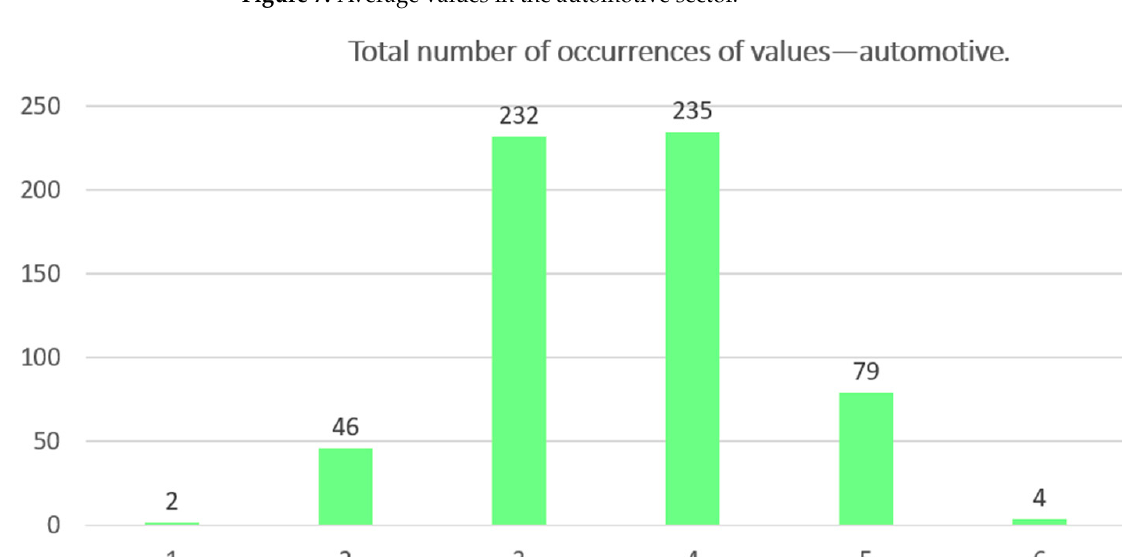
Figure 8. Total number of occurrences of values—automotive .